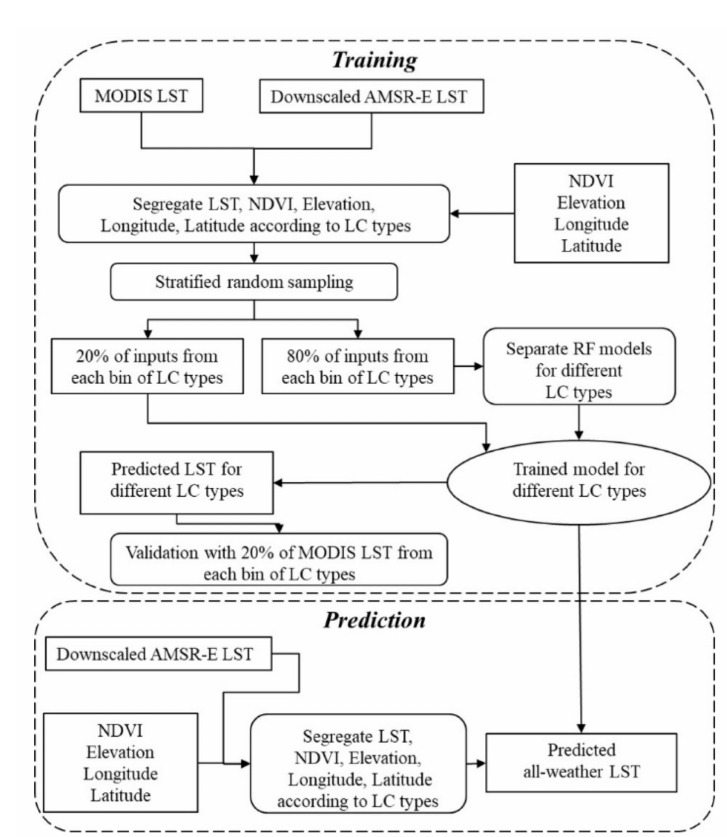
Figure 2. The flowchart for implementing model